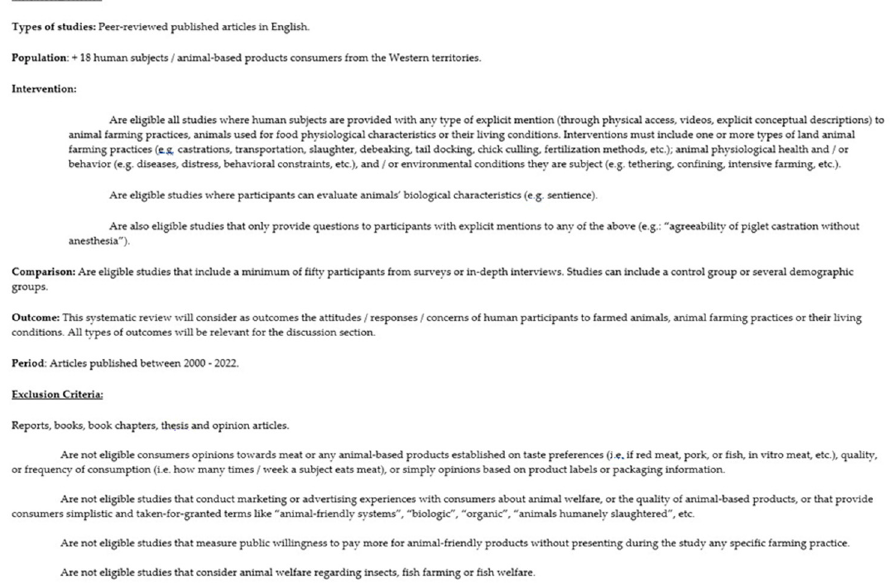
Figure 2. Eligibility criteria.